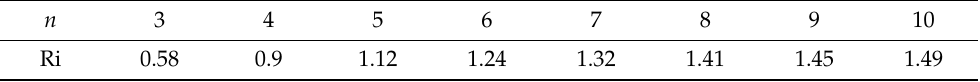
Table 3. Random indicators (Ri)